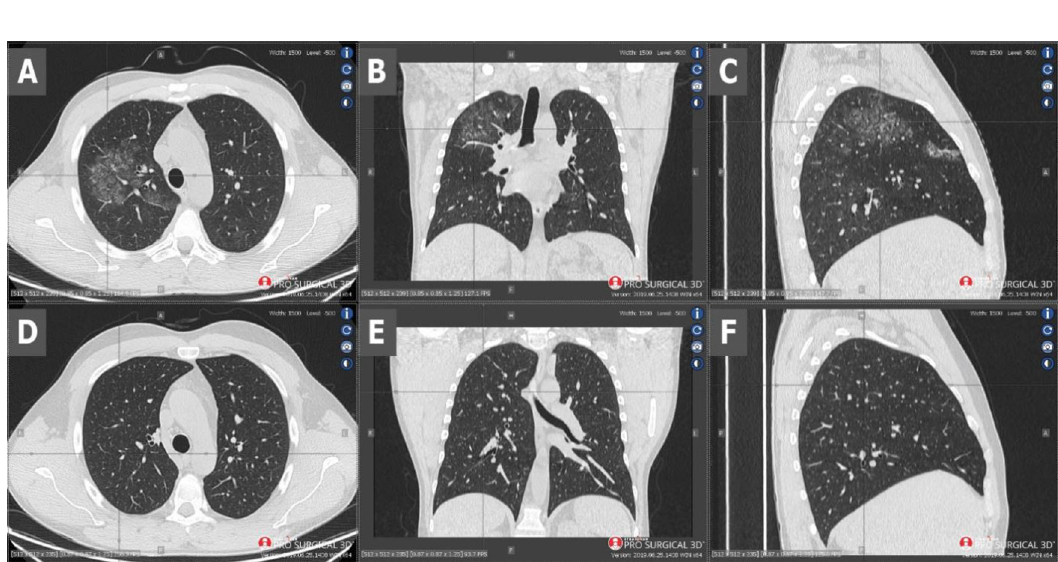
Figure 1. Scans A-C - CT performed on admission - scans show diffuse ground-glass opacities and septal interlobular thickening in the right lung, as well as paving-stone findings which could represent alveolar haemorrhage. Scans D-F - CT performed 2 months later - visible radiological